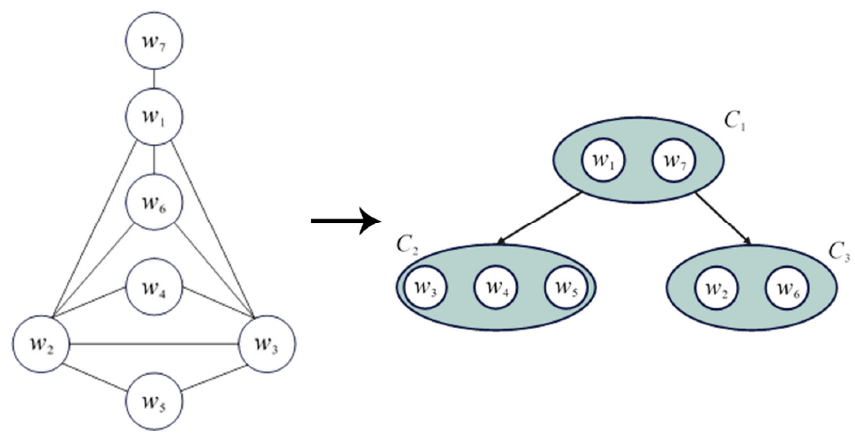
Figure 7. Combat unit tree segmentation results. Use VWNF-PSO, AFPSO and VWPSO to optimize the set of three combat units sun- sets { C 1 , C 2 , C 3 } respectively. Set the inertia weight of AFPSO as w = 0.8, and the learning factor of VWPSO as c 1 = 0.5, c 2 = 0.5, obtain the target allocation